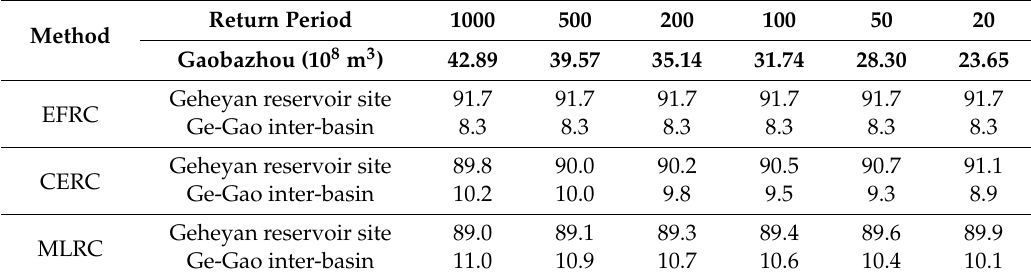
Table 4. Regional three-day flood volume proportions at Gaobazhou reservoir site